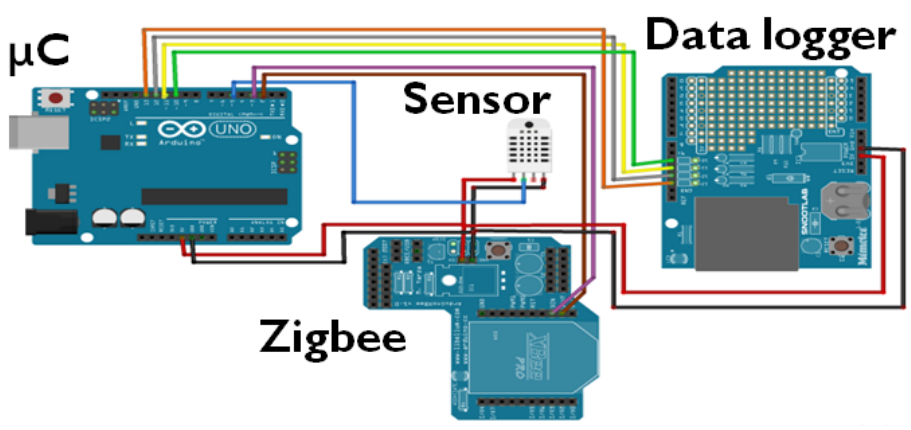
Figure 6. Environment sensing node annotated schematic diagram.